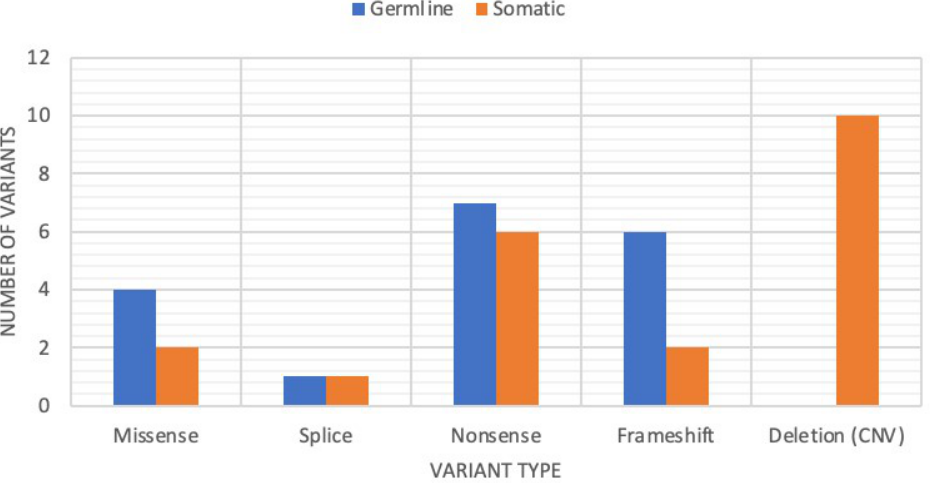
Figure 2. Distribution of variant type based on variant origin. Large full-gene copy-number variation (CNV) deletion events were only observed as somatic in origin while all other variant types were observed across both types of inheritance.